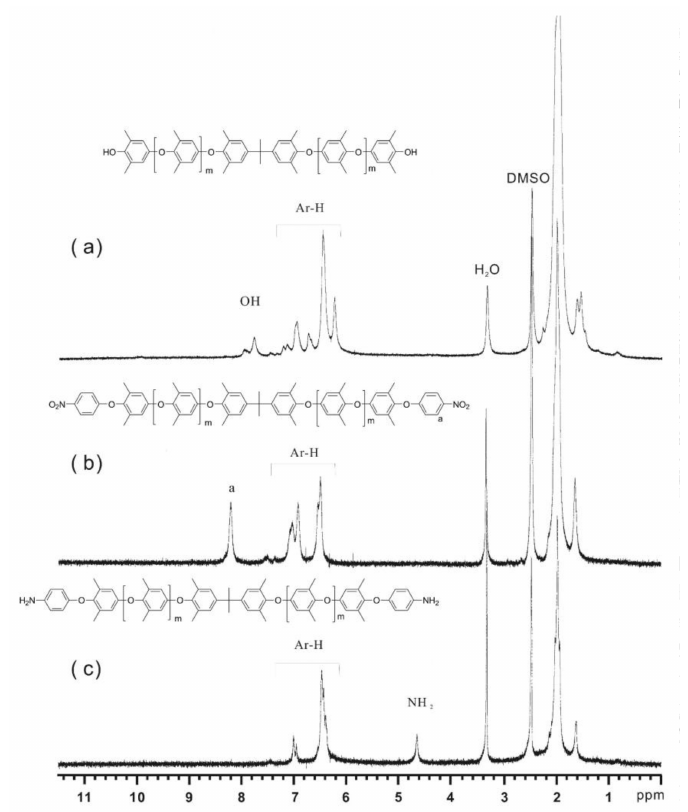
Figure 2. 1 H-NMR spectra of ( a ) SA90, ( b ) NPPO, and ( c ) APPO in DMSO- d 6 .